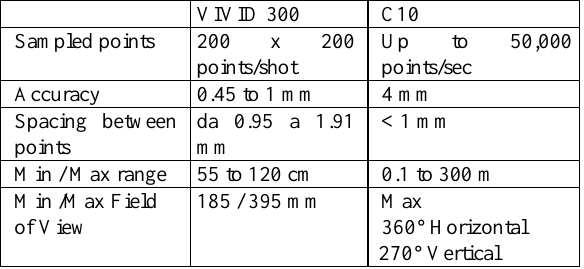
Table 1. Vivid 300 Minolta and Leica C10 characteristics